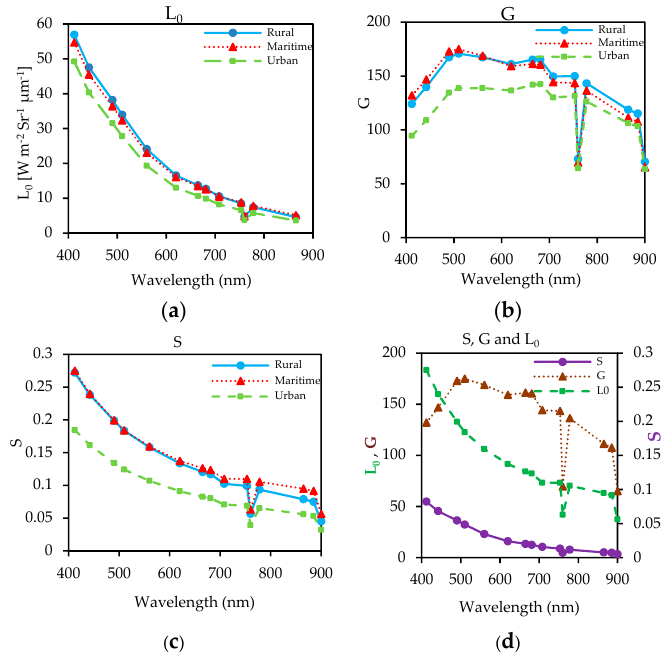
Figure 4. ( a – c ) L 0 , G and S values at the visibility of 20 km and different aerosol types; ( d ) The atmospheric parameters L 0 , S and G for the maritime aerosol type and a visibility of 20 km.